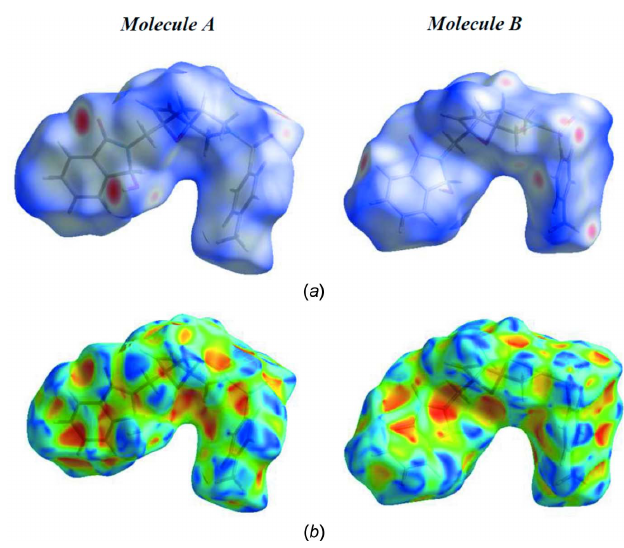
Figure 5 ( a ) View of the three-dimensional Hirshfeld surfaces for molecules A and B of the title compound 3 ; ( b ) Hirshfeld surfaces plotted over shape- index.